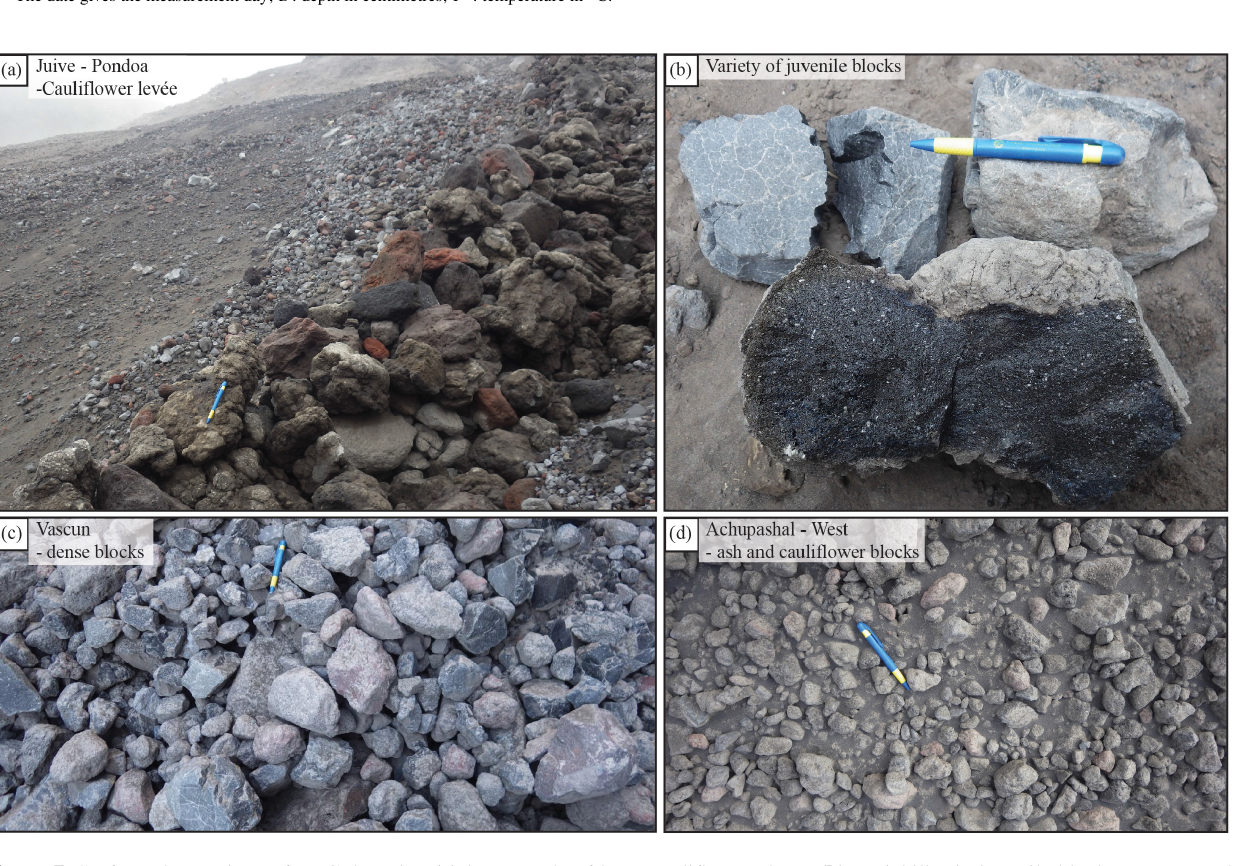
Figure 7. Surface observations of PDC deposits: (a) levee made of large cauliflower clasts. (b) Variability in juvenile blocks encountered, with dense (top left), cauliflower (lower part), and bread-crusted (top right) clasts. (c) A fines-depleted surface with large blocks vs. (d) a fines-rich surface with smaller blocks. Same pen for scale in each